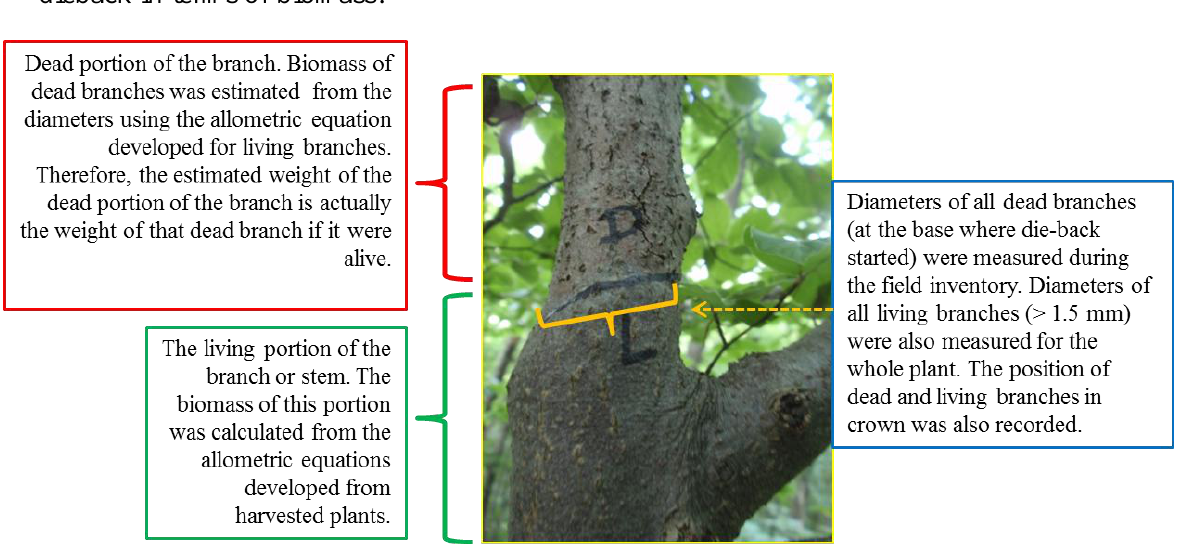
Figure 11. Schematic representation of the simulation method to quantify the crown dieback in terms of